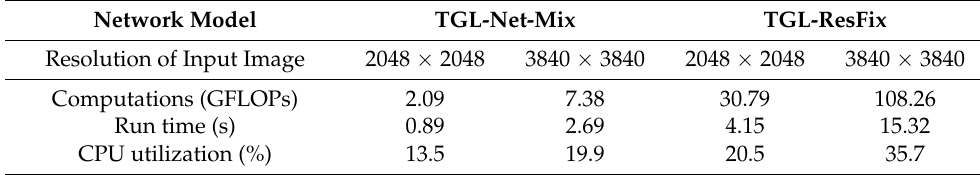
Figure 10. Loss curves for training TGL-Net-Mix by setting different values of loss trade-off pa- rameter α , which is set from 0 to 0.5 with an increment of 0.1. For a better illustration, both vertical axes are shown in logarithmic scale. One iteration corresponds to training a batch of images with a batch size of 16. ( a ) Loss curve in iterations from 0 to 600; ( b ) loss curve in iterations from 4 × 10 4 to 5 × 10 4 . Table 11. Average values of non-reference measures on NTIRE datasets. Table 11. Average values of non-reference measures on NTIRE datasets.